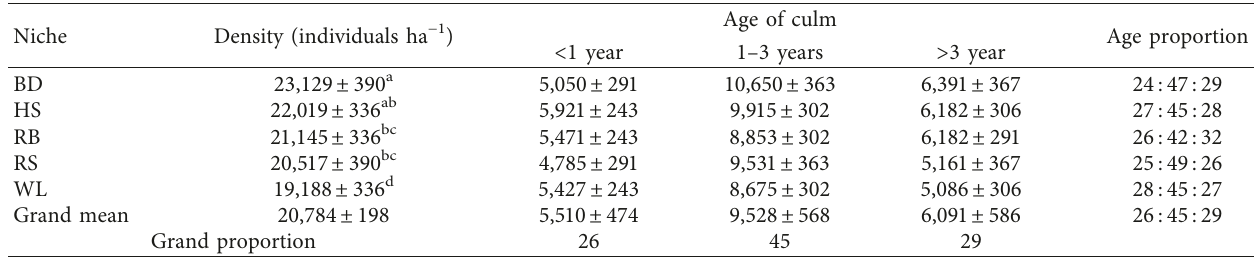
Figure 4: Height distribution of bamboo culms (BD � boundary; HS � homestead; RB � river bank; RS � roadside; WL � woodlot plantation niches). Table 1: The density and age composition of bamboo culms (mean standard ± error).